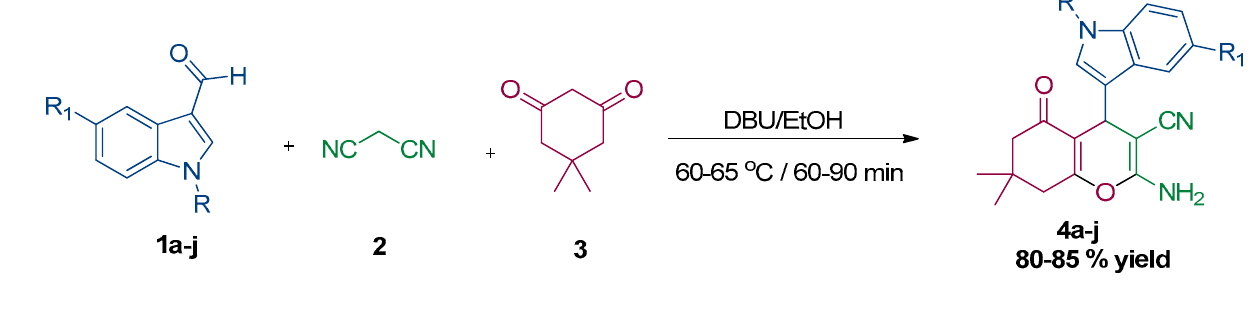
Table 2. Optimization of the amount of DBU.